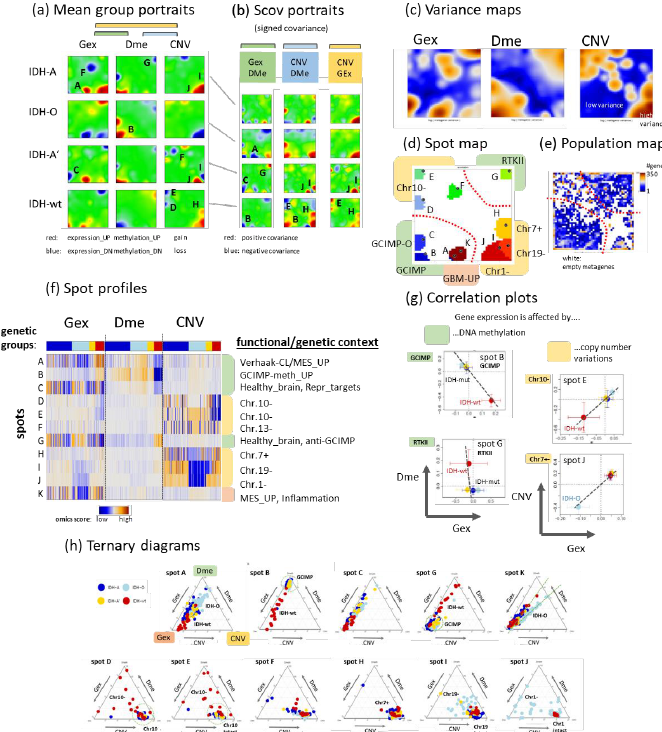
Figure 4. SOM portrayal of the gene expression (Gex), DNA methylation (Dme), and CNV landscapes. ( a ) Mean portraits of the genetic groups indicate characteristic features as red (increased values) or blue (decreased values) spots which are labelled by capital letters. The full gallery of individual portraits is shown in Figure A1. ( b ) ScoV portraits show cross-correlations between pairwise combina- tions of omics features. Gex and Dme predominantly anti-correlate (blue spots) reflecting repressive effect of DNA promoter methylation on gene activity while CNV and Gex/Dme mostly positively correlate (red) reflecting dose–response relationships. ( c ) Variance maps colour code the gene space for high (maroon colour) to low (blue) variance of the respective omics score. The variance patterns of Dme and CNV distribute along the two perpendicular diagonals, thus reflecting partial independence while the Gex pattern mixes with them. ( d ) The spot map shows the areas of the map with high feature values in any of the group portraits. They are observed predominantly in the Gex (red colour along the frame), Dme (green) or CNV (yellow) domains and are labelled by capital letters A–K in a clockwise direction. ( e ) The population map visualizes the population of metagenes with single genes. In the Dme- and Gex dominated regions (lower left to upper right diagonal), genes are more smoothly distributed while the CNV domain is characterized by an “isolated island”-like distribution of genes. ( f ) Spot profiles in the three omics domains and their functional/genetic context indicate increased (red) and decreased (blue) feature scores. Details are provided in Table A1 (Appendix B) and Supplementary Table S1. ( g ) Correlation plots of genes from selected spots reveal negatively cor- related repressive relations between Dme and Gex and positively correlated dose–response relations between CNV and Gex. ( h ) Ternary diagrams of the feature composition in each spot and tumour. Point clouds along the left Gex axis are driven by changing methylation (upper row of diagrams) while the lower row refers to spots governed mostly by CNV Gex dose